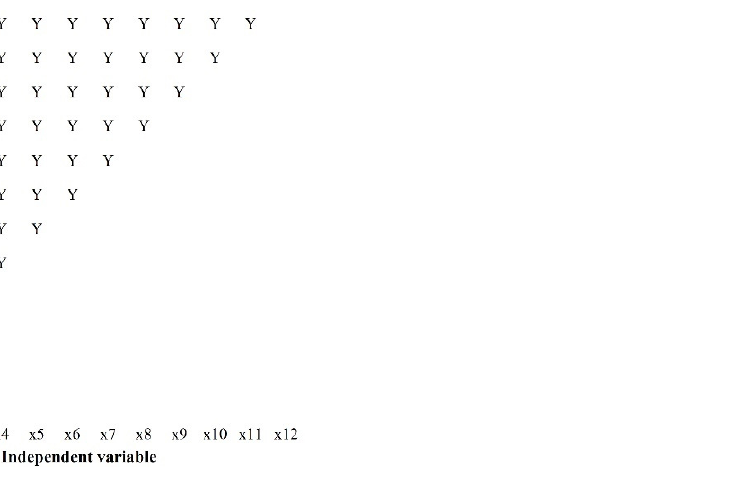
Figure 10. Ecological detection results. Notes: “Y” indicates that there is a significant difference between the two independent variables on desertification sensitivity. “N” indicates that there is no significant difference between the two independent variables on desertification sensitivity.